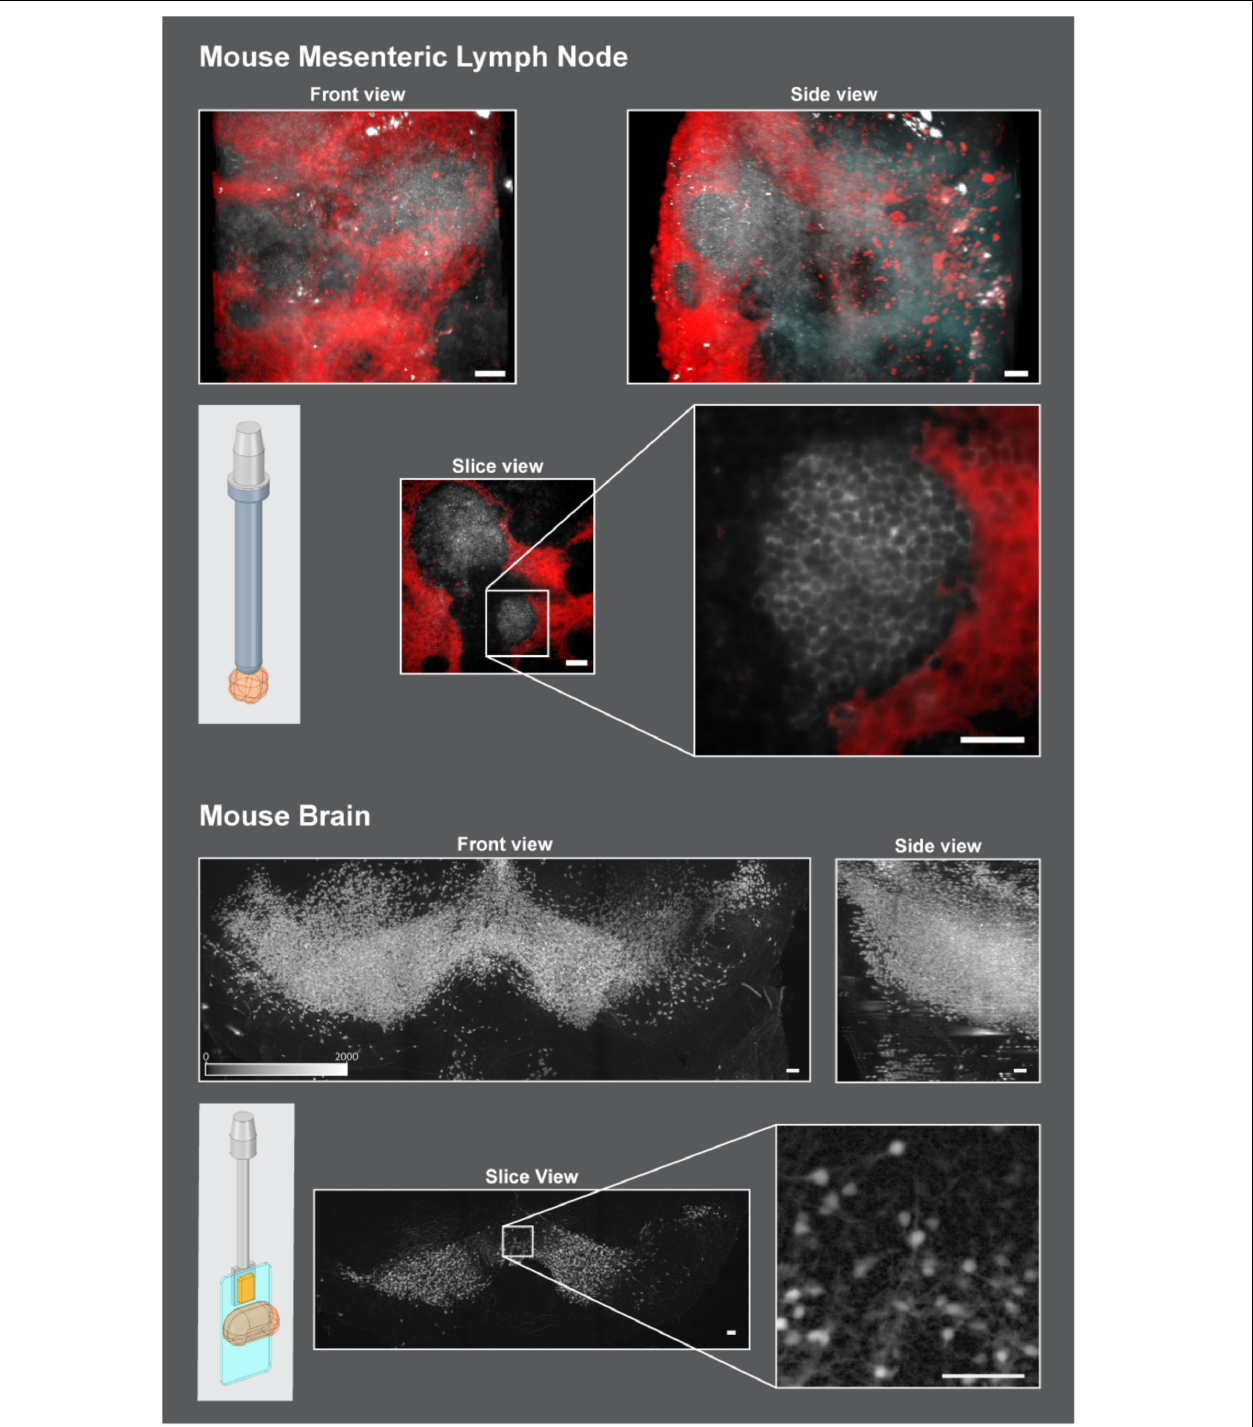
FIGURE 5 | Mounting strategies in two use cases. Top: Cleared mouse mesenteric lymph node was glued onto a LEGO antenna and attached to the sliding rod holder with the LEGO adapter. Scale Bars = 50 um. TOP: Front views and side views of lymph node are shown to showcase the extents of width, height, and depth that can be acquired on this system with the sliding rod holder. The slice view represents a single slice roughly in the middle of the stack to show the resolution obtained. Bottom: Active Clarity Cleared mouse brain (Lee et al., 2016) was glued to a plastic coverslip and held in place onto the sliding rod holder with the slide adapter and a neodymium magnet ( Figure 3b ). 2 × 3 tiled acquisitions were performed to reconstruct the structure shown here. Scale bars = 100 um. To enhance tissue boundaries, images were gamma adjusted (gamma = 0.5). Schematic images on the top and bottom left of the figure show how the sample (orange) was mounted to work in the microscope using the developed adapters: top: LEGO adapter ( Figure 3d ), bottom: slide adapter ( Figure 3a ).